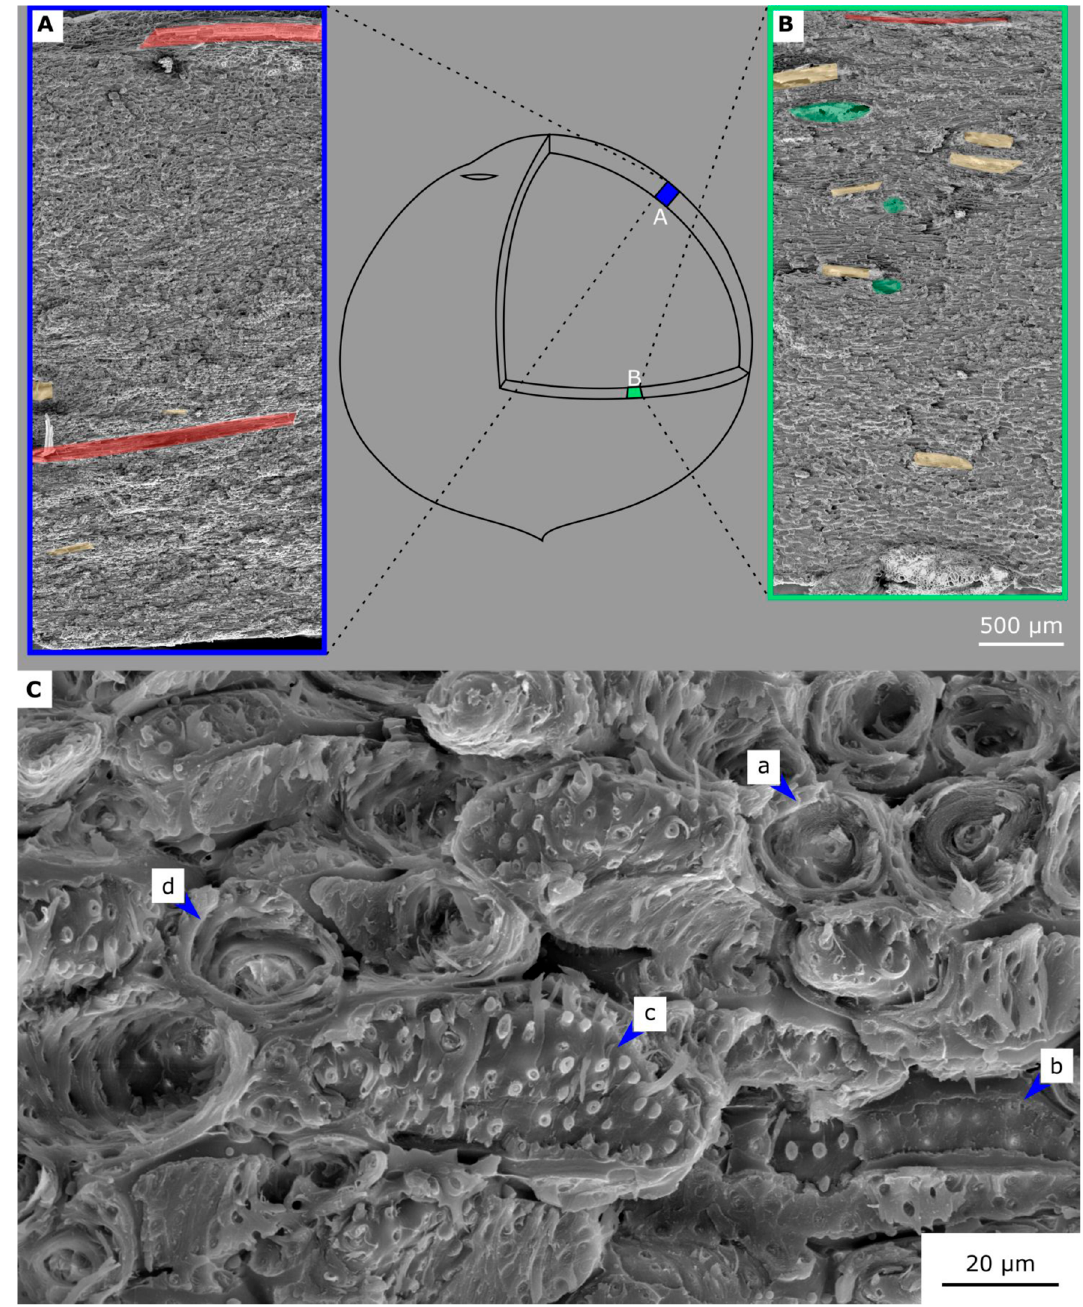
Figure 11. SEM images of fracture surfaces broken in meridional/sagittal plane ( A ) and equatorial/transverse plane ( B ). Vascular bundles parallel to the fracture surface are marked red, the perpendicular ones are green, and the oblique ones are yellow. The detail of a broken sclereid cell matrix ( C ) highlights the four failure modes (modified after [5]: Cell tearing (a), middle lamella breakage (b), cell wall breakage (c), and pull-out of elongated cells